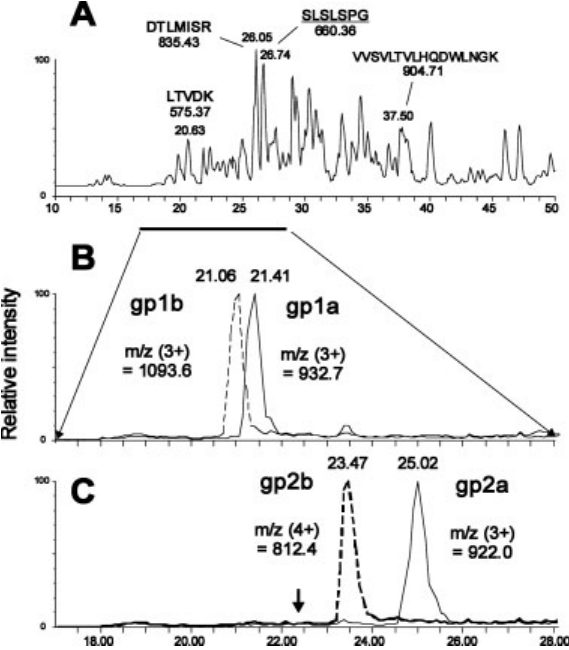
Figure 2. RPC-MS of peptides and glycopeptides from human IgG. (A) Part of the base peak intensity (BPI) chromatogram of hIgG. Four easily identifiable IgG1 peptides are labeled, among them the Lys-truncated C-terminal peptide SLSLSPG. (B) The SIM traces for the IgG1 glycopeptides gp1a and gp1b being the fully cleaved peptide (EEQYNSTYR) and the incompletely digested version with an N-terminal TKPR. (C) The SIM trace for IgG2, wheregp2a hasthe sequence EEQFNSTFR and gp2b is thelonger versions. The arrow in (C) gives the elution position of the glyco- peptide from IgG4 (and the A2NU35 variant of IgG3).